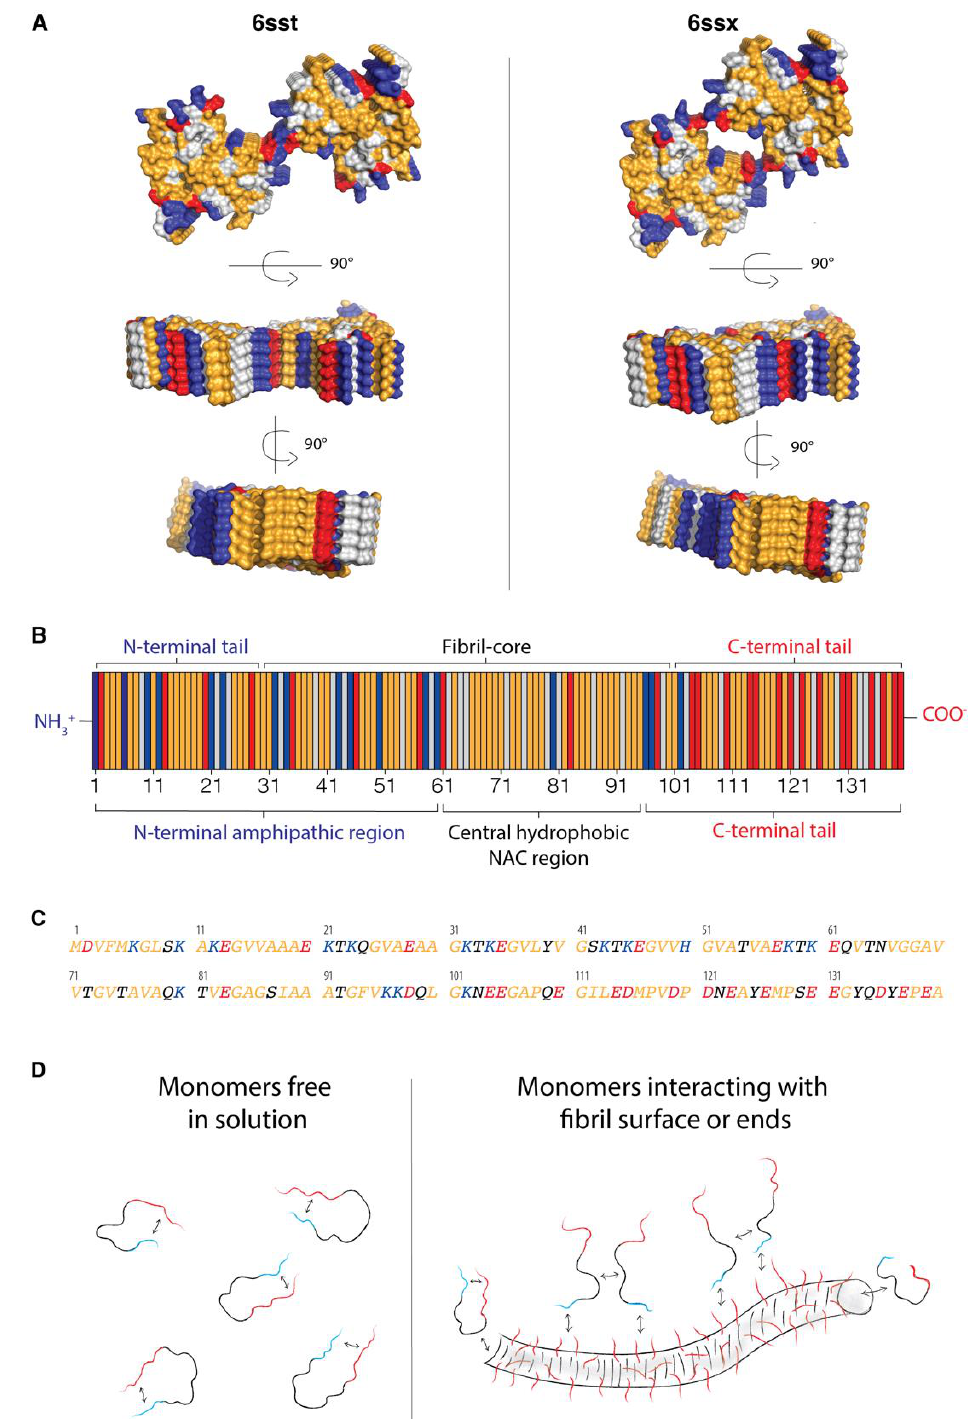
Figure 1. Structure, surface properties, sequence, and interaction modes of α -synuclein monomers and fibrils. ( A ) Examples of structures of α -synuclein fibrils with two different morphologies (PDB: 6ssx and 6sst) containing two protofilaments each. Both structures are solved for residues Gly14- Gly25 and Gly36-Lys96; the N- and C-terminal tails are not part of the ordered structure. The figures are generated in Pymol. Each structure is shown from three different angles. Both structures are shown from the same angles for comparison of the surface properties of the two morphologies. Residues are colored according to their properties: acidic (red), basic (blue), hydrophobic (yellow), and non-charged polar residues (light gray) ( B ) Distribution of acidic (red), basic (blue), hydropho- bic (yellow), and non-charged polar residues (light gray). At the top, the sequence is divided into three regions according to how the monomer folds into the fibril structure (2NOA.pdb): the N-ter- minal tail (residues 1 – 28), the fibril core (residues 29 – 100), and the C-terminal tail (residues 101 – 140). At the bottom, the sequence is divided into the three regions according to sequence properties: